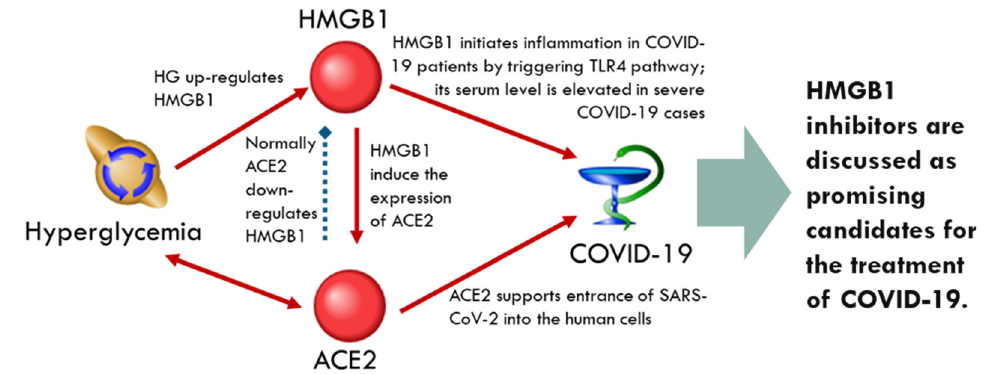
Figure 4. Positive feedback loop that involves HMGB1 in ACE2-related network. The red arrows correspond to the up-regulation and the blue arrow corresponds to the down-regulation.